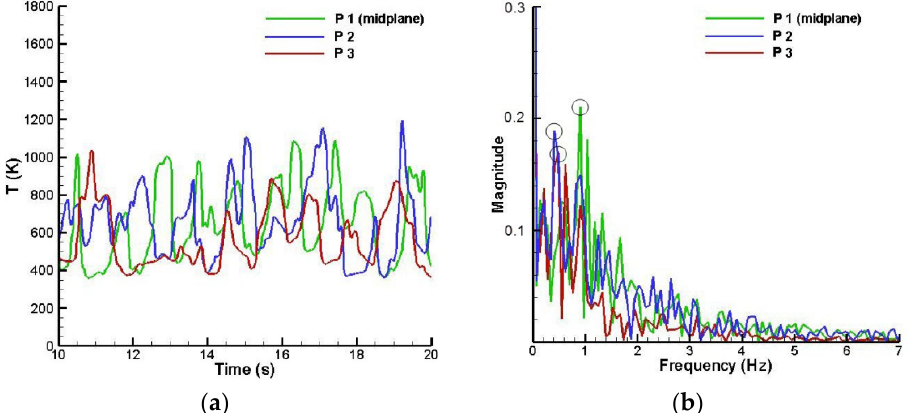
Figure 3. Subfigure ( a ) shows the instantaneous surface temperature as measured in Degrees Kelvin at 3 points located on the surface 5 m from the building front. P1 is directly on the building’s center line, whilst P2 and P3 are located 9 m on either side of the center. Subfigure ( b ) shows the frequency of peak temperature signals at these same sensors [33] (p. 12).